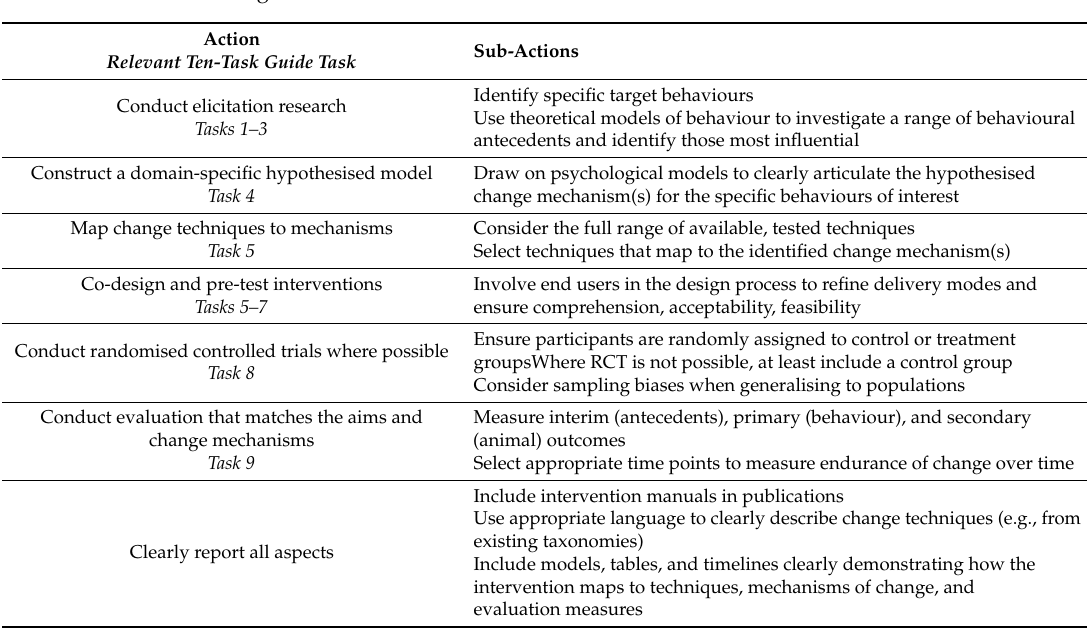
Figure 4. The Pet Care Competency Model: an example of a domain-specific theoretical model, adapted from [99]. Table 3. Recommendations to improve research into behaviour change interventions in animal care and interactive